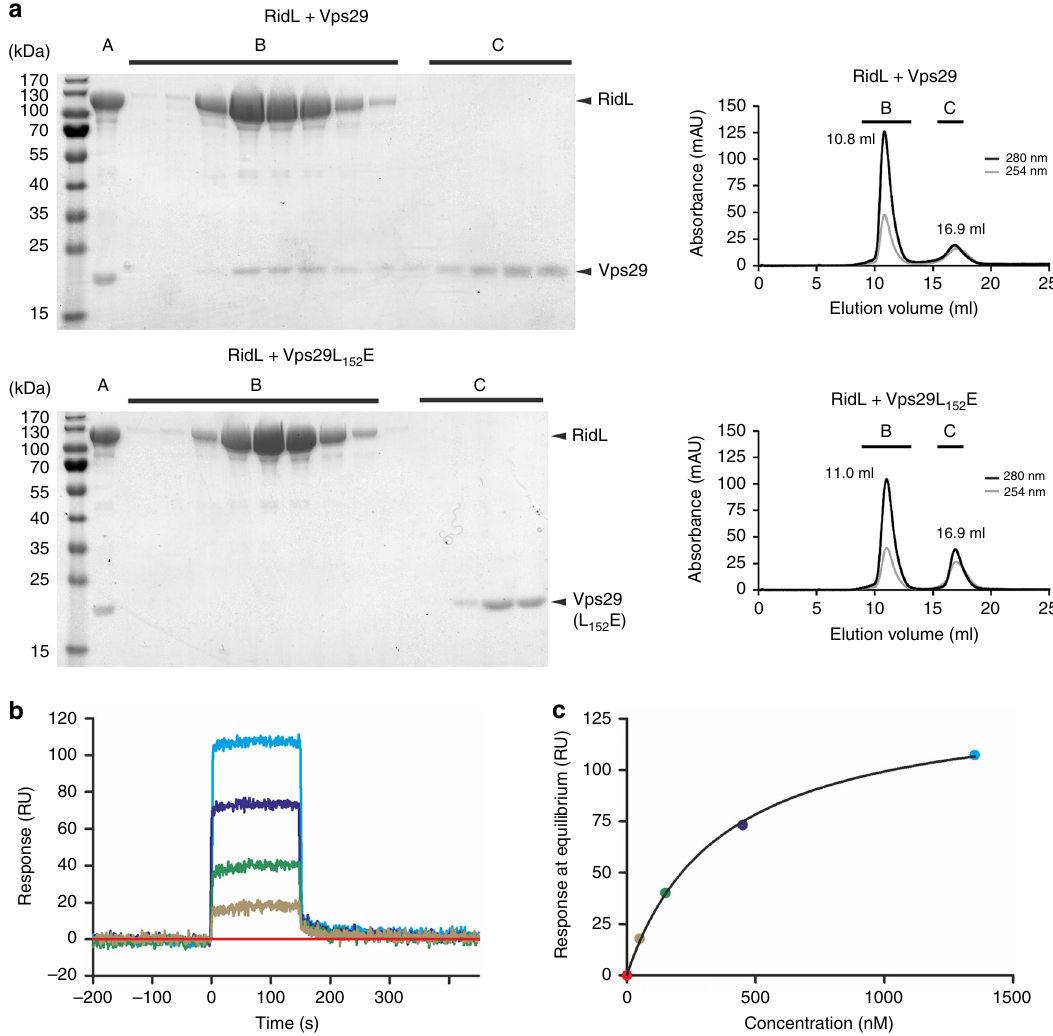
Fig. 3 RidL binds Vps29 but not Vps29 L152E in vitro. a For size-exclusion chromatography (SEC), RidL (132 kDa) was mixed in a molar ratio 1:1.5 with Vps29 (21 kDa) or Vps29 L152E (21 kDa). SDS-PAGE and Coomassie Brilliant Blue staining of (A) input (ratio 1:1.5), (B) SEC elution fractions 9 – 13 ml (elution volume RidL or complex), and (C) SEC elution fractions 15.5 – 17.5 ml (elution volume Vps29 or Vps29 L152E ) were analyzed. SEC elution pro fi les are shown, analyzed fractions are labeled and elution peak elution volumes are indicated. The peak shift for the RidL – Vps29 complex is 0.2 ml relative to RidL alone. b For surface plasmon resonance (SPR) measurements, biotinylated RidL was used as ligand and Vps29 as analyte. Concentration series: red, 0 nM; brown, 50 nM; green, 150 nM; blue, 450 nM; cyan, 1.35 μ M. c Response units (RU) obtained at binding equilibrium of each Vps29 concentration shown in b are plotted against concentration (nM). An equilibrium constant K D of 400 nM was calculated from the fi t as indicated in the Materials and Methods chip and puri fi ed Vps29 served as the analyte (Fig. 3b). The rates